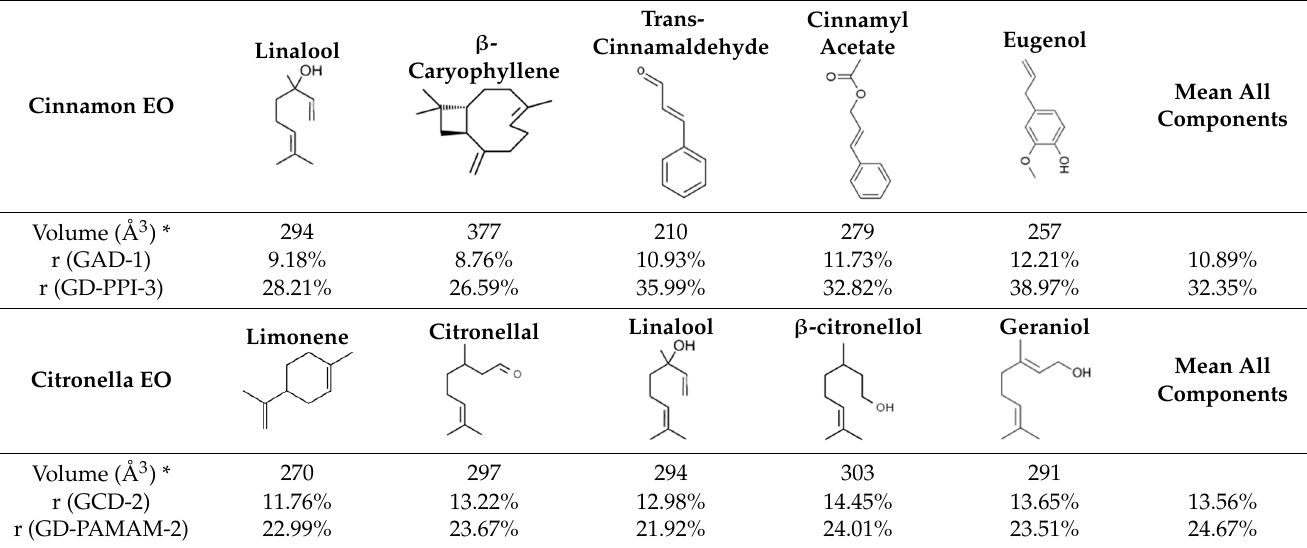
Figure 3. Overlaying of chromatographic analysis of free Java citronella EO (control) and Java citronella EO encapsulated within GD-PAMAM-2 under optimized conditions—(1) ethanol (sample solvent), (2) limonene, (3) citronellal, (4) linalool, (5) β -citronellol, (6) geraniol. Table 5. Chemical structures and calculated molecular volumes of the major compounds of cinnamon and Java citronella EOs; and their individual retention rate in the optimized encapsulation within dendrimers.